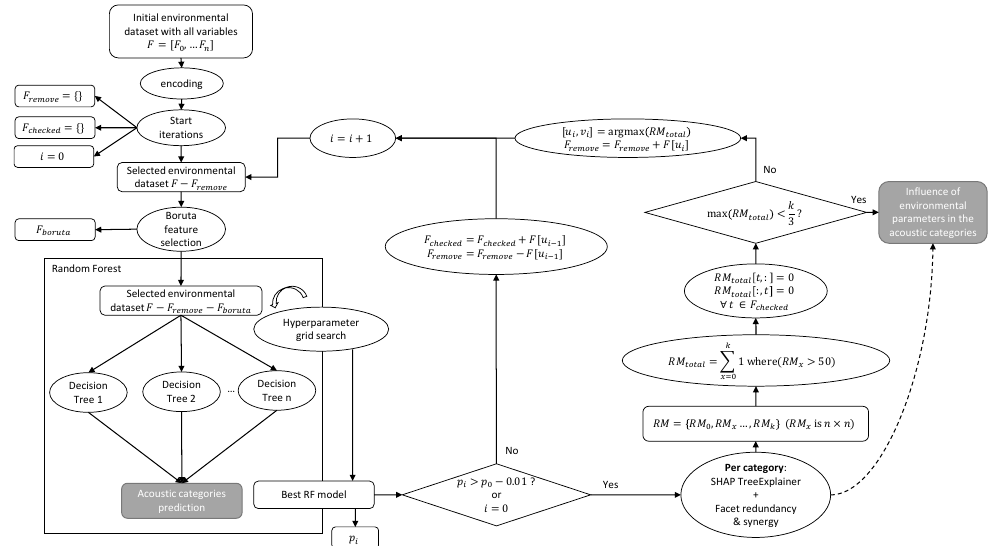
Figure 2. Diagram of the trained Random Forest and the environmental characteristics assessment: k is the number of categories; i is the iteration number; F are all the available variables; n is the number of available variables; p i is the performance of iteration i ; RM is the redundancy matrix nxn , with the “perspective” feature as rows; the dashed line illustrates the basis of the